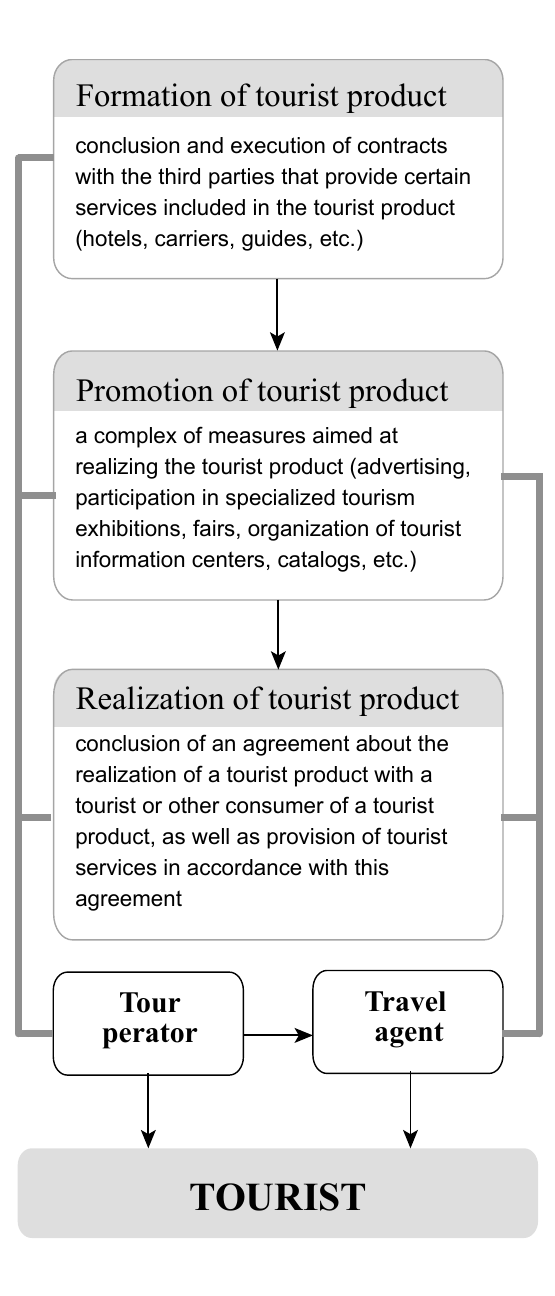
Figure 4 . The main stages of